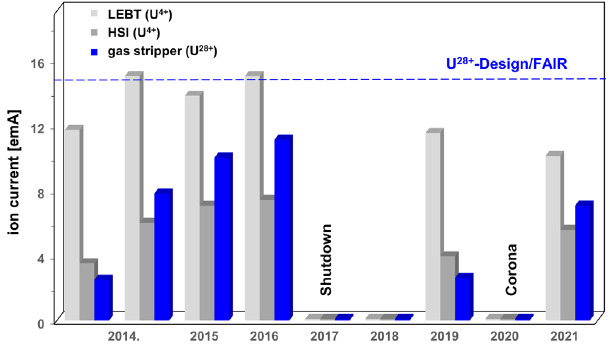
FIG. 2. Uranium beam intensities along the HSI from 2014 to 2021.